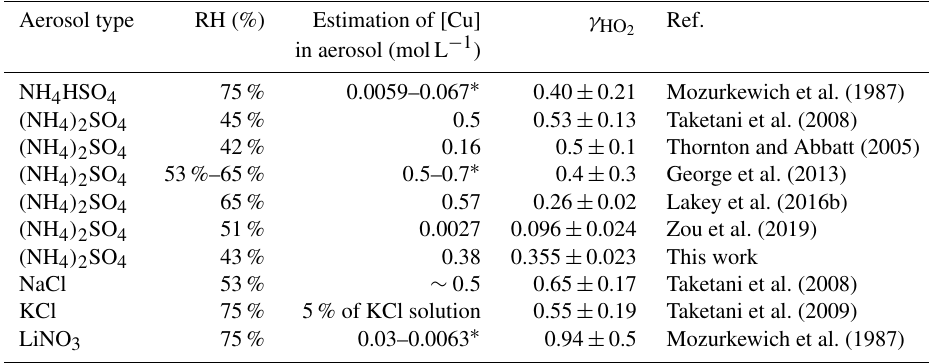
Table 1. γ HO determined under laboratory conditions for copper-doped inorganic aerosols. 2 Aerosol